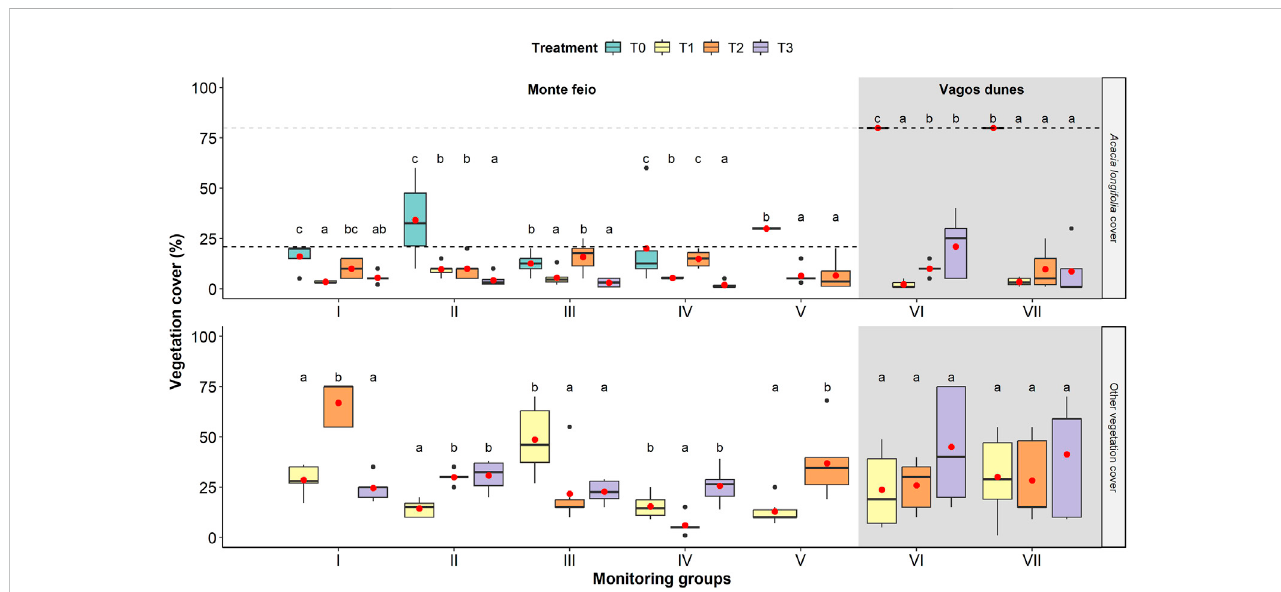
FIGURE 2 Acacia longifolia (left) and other vegetation (right) cover after each treatment (T1, T2, and T3) on different monitoring groups. Monitoring group V had onlytwotreatments(T1andT2).LettersabovewhiskersshowresultsofTukeypost-hoctest.Thethickhorizontallineineachboxindicatesthemedianandthe redpointindicatesthemean;thebottomandtopofeachboxindicatethe25thand75thpercentiles,respectively.Theverticallines(whiskers)representeither the maximum/minimum value or 1.5× interquartile range, whichever is closer to the mean. Dark points represent outliers. For details regarding each monitoring group, see Table